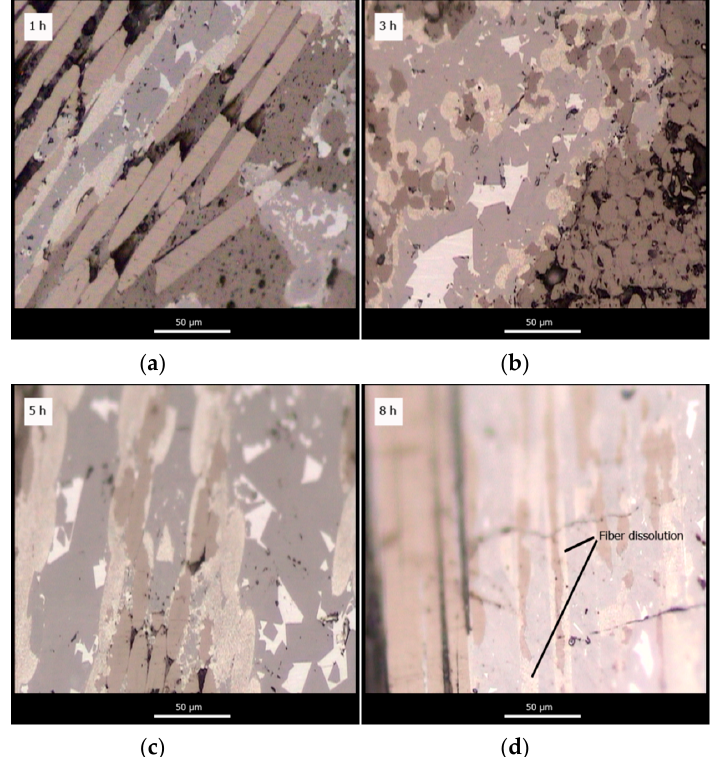
Figure 13. Evolution of carbon fibers during infiltration with a 1 h ( a ), 3 h( b ), 5 h ( c ) and 8 h ( d ) dwell time.